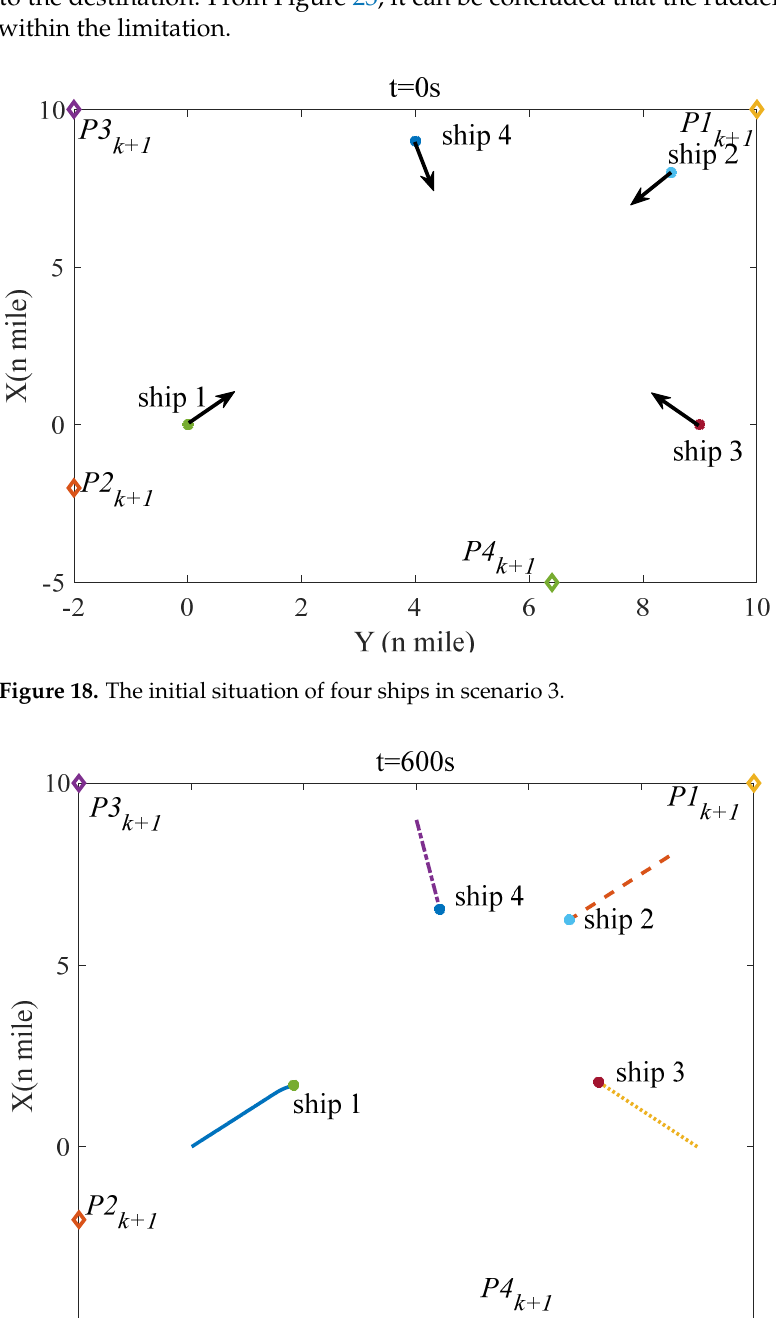
Figure 20. The situation of four ships at t = 2400 s in scenario 3.